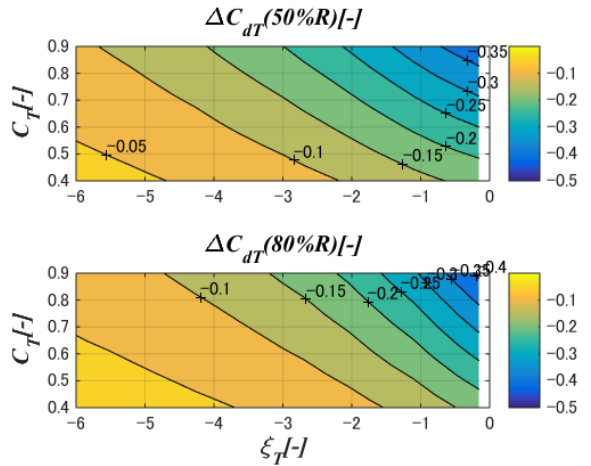
Figure 13. Relationship between the tower section drag and rotor thrust and the virtual tower position. Δ C dT , drag coefficient.